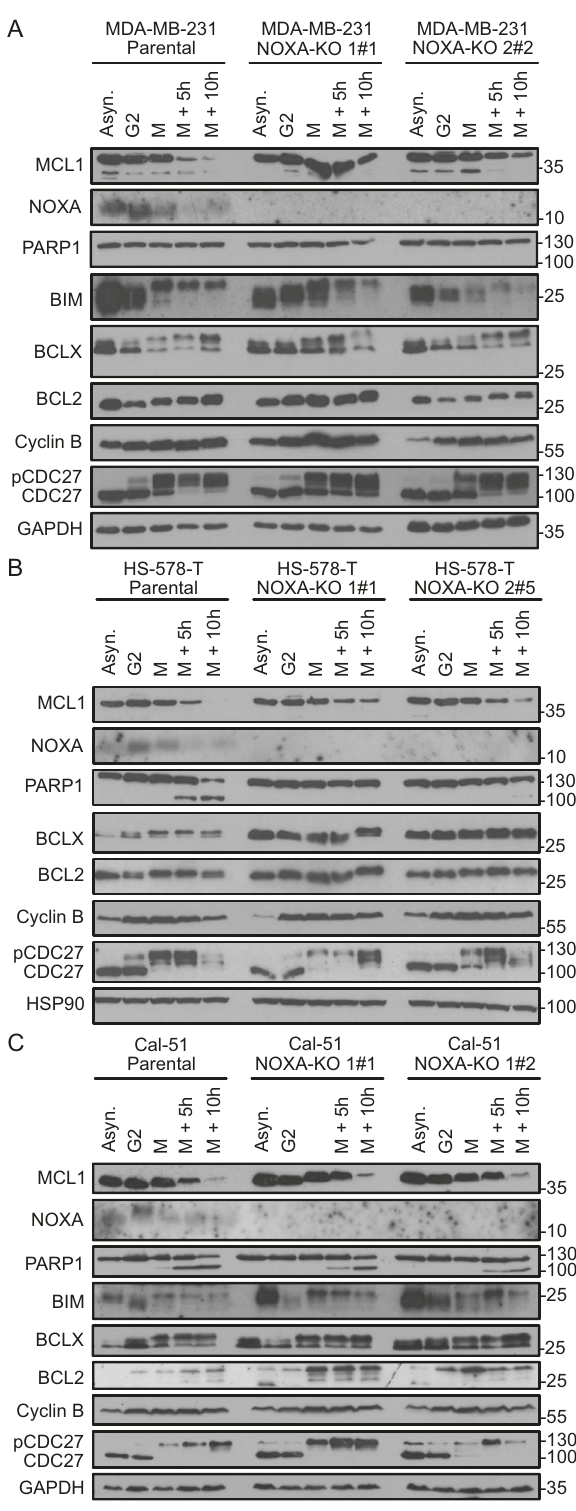
Fig. 5 TNBC cell lines treated with paclitaxel show MCL1 and NOXA co-degradation. A – C TNBC pro fi cient (Parental) or de fi cient in NOXA (NOXA-KO) were left asynchronous (Asyn.) or synchronised with a double-thymidine block and released into 500 nM PTX. Cells were harvested in G2 and early M-phase (M); part of the M-phase cells was reseeded and harvested 5 h (M + 5 h) and 10 h (M + 10 h) later. Harvested cells were subjected to western analysis using the indicated